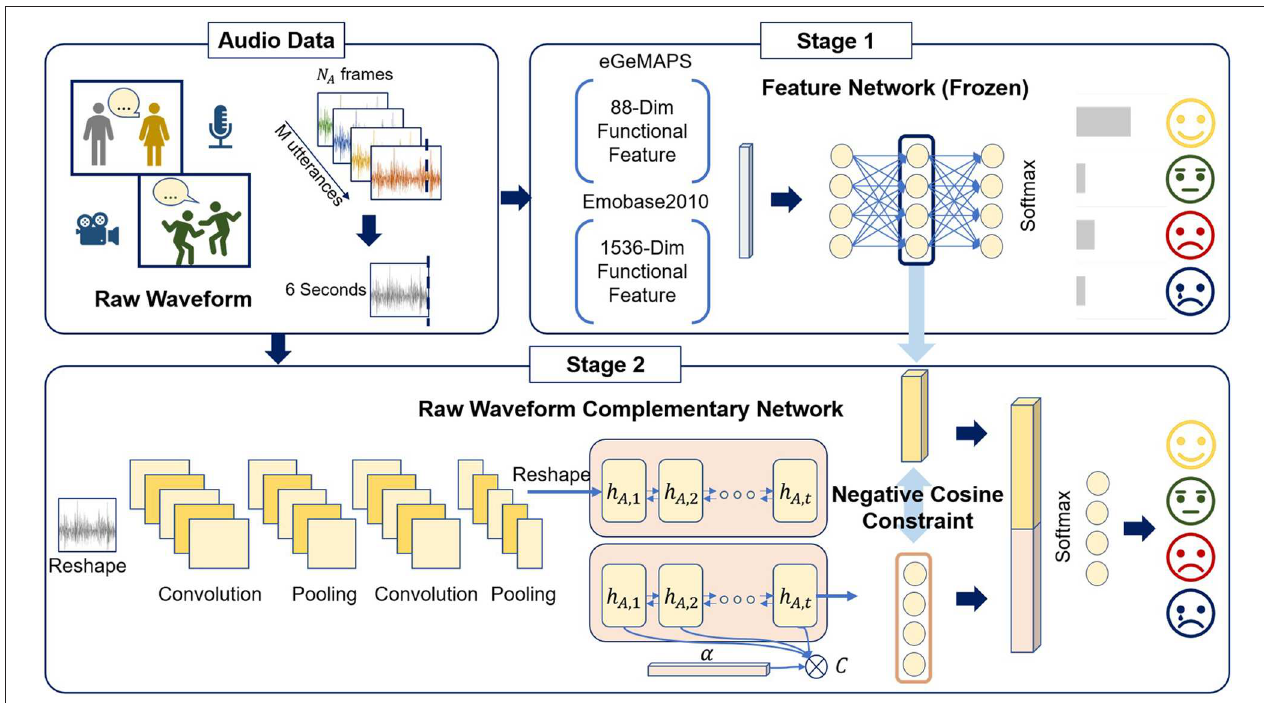
FIGURE 3 | This is an overall schematic of our proposed Dual Complementary Acoustic Embedding Model (DCaEN) framework. The training process contains two stages: the first stage is learning the Feature Network and freezing the network; the second stage is building an end-to-end architecture to learn complementary embedding from raw waveform based on negative cosine loss constraint to the learned frozen Feature Network embedding. We finally concatenate both embeddings to perform the final emotion